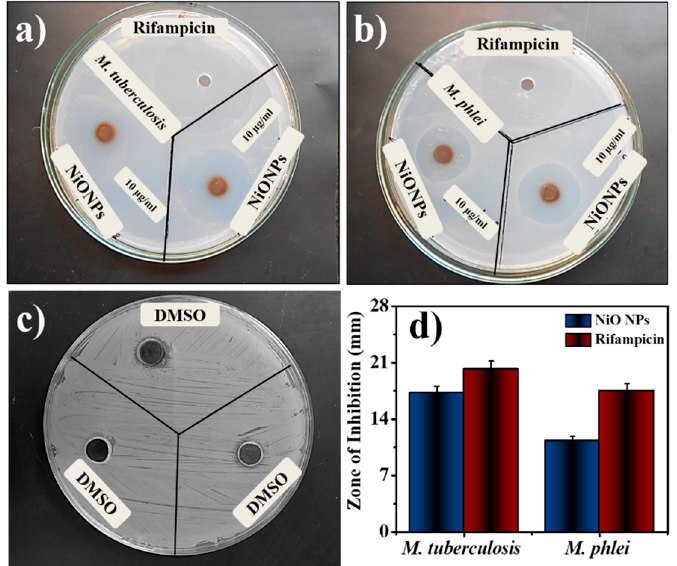
Figure 3. Antimycobacterial activity by using agar plates ( a ) M. tuberculosis , ( b ) M. phlei, ( c ) DMSO, and ( d ) comparative bar graph.